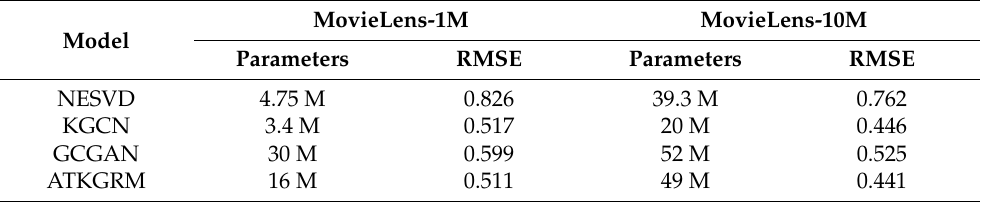
Table 9. The number of parameters and the results of RMSE on different models (M denotes “million”).